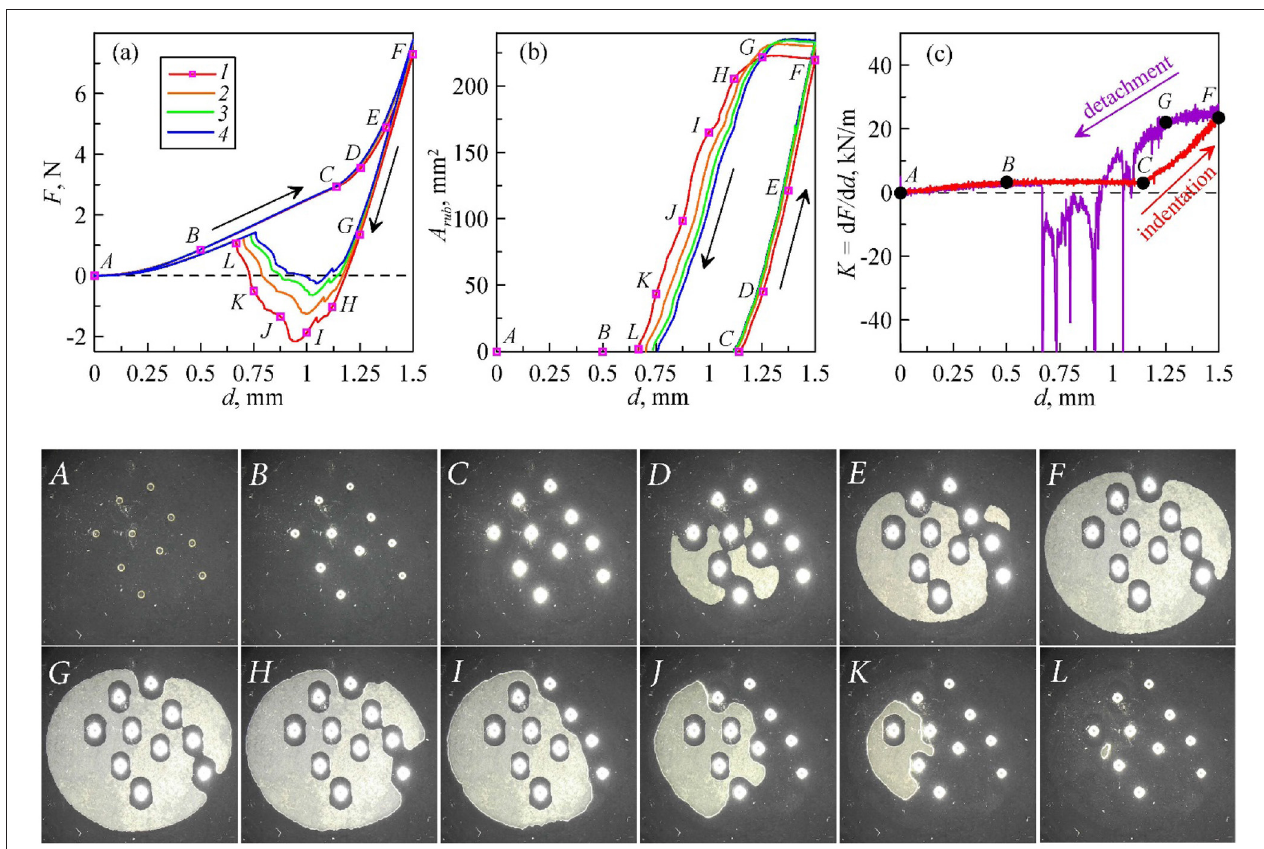
FIGURE 8 | Experiment of indentation test with 10 identical micro steel spheres (diameter 1mm). Dependences of the normal force (a) , direct contact area between elastomer and indenter (b) , and contact stiffness (c) on indentation depth d . Solid lines with different colors show the results of four cycles in a series. Dependence of contact stiffness is shown only for the first indentation cycle. The snapshots below show contact areas in a region with size 22mm × 22mm for the first indentation